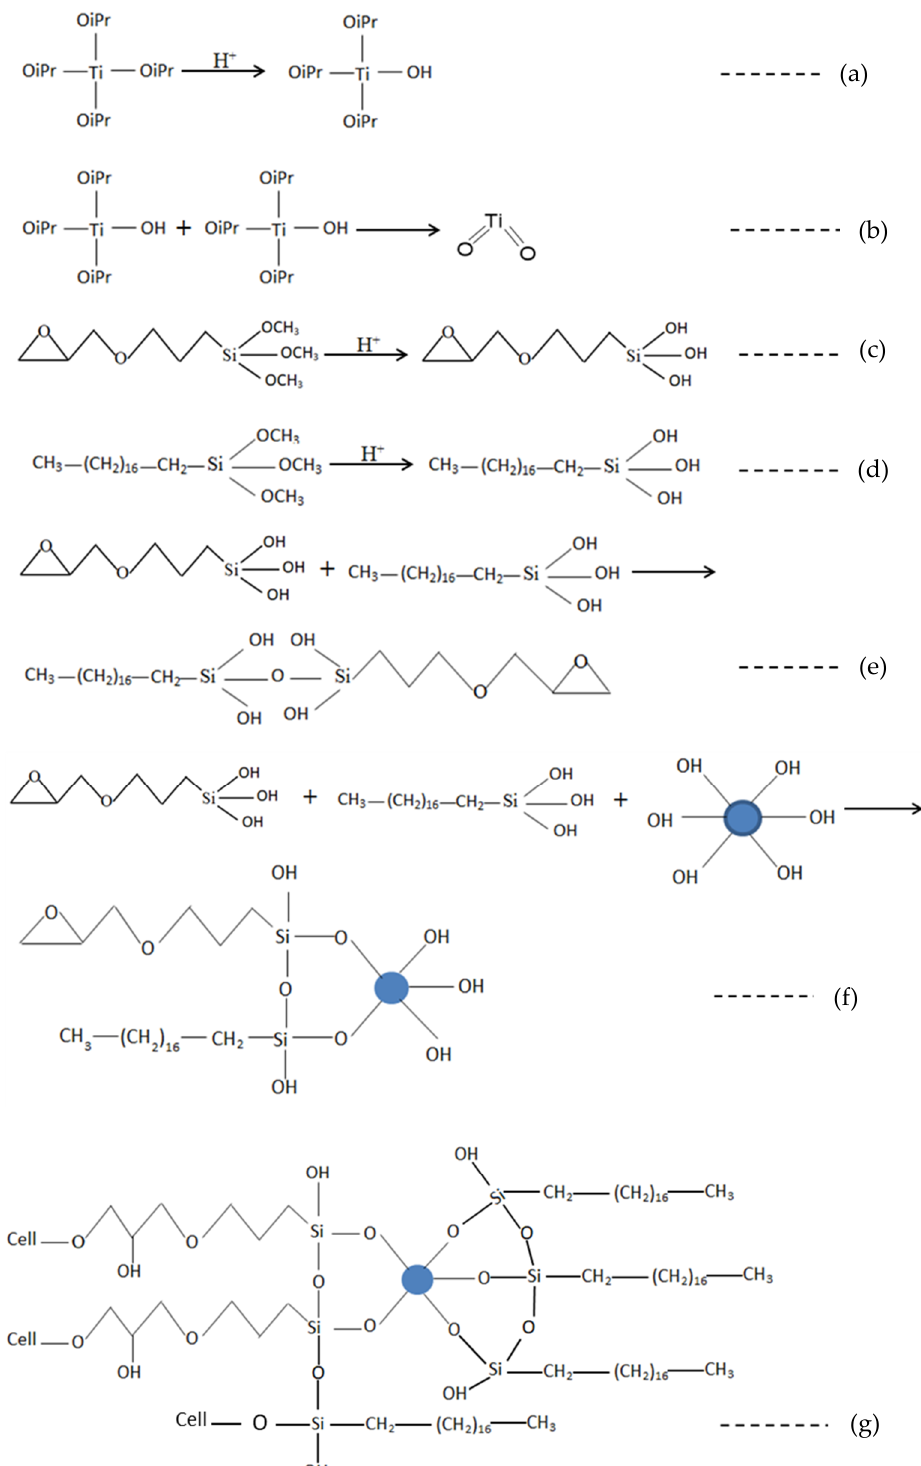
Figure 9. Various reactions expected during the process, ( a ) Hydrolysis of titanium isopropoxide. ( b ) Condensation reaction to form nano titania. ( c ) Hydrolysis of GPTMS. ( d ) Hydrolysis of ODS. ( e ) Condensation between hydrolysed GPTMS and ODS. ( f ) Synthesized modified nano titania with GPTMS and ODS. ( g ) Condensation between cellulose and synthesized modified nano tita- nia.